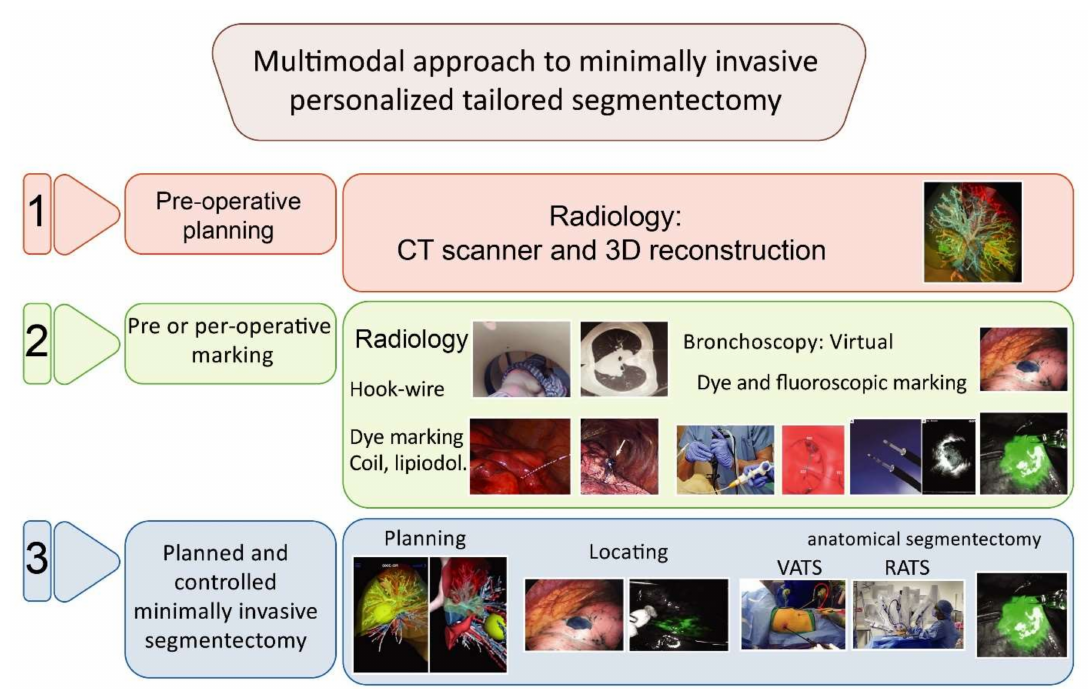
Figure 1. Multimodal approach to minimally invasive personalized tailored segmentectomy in 3